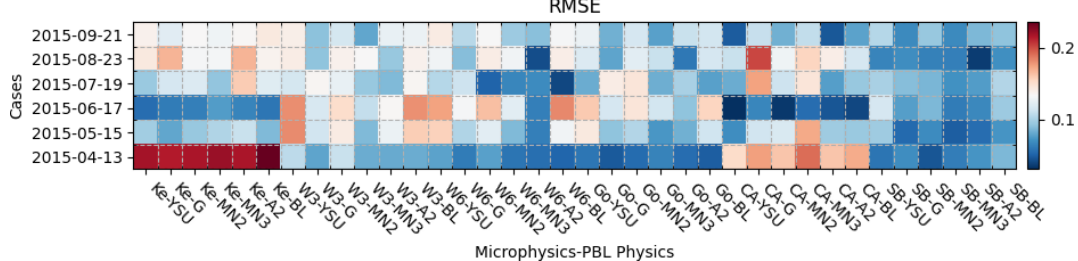
Figure 16. Heat map of the RMSE between the ensemble mean total cloud fraction and observation, averaged over the last 36h of the simulations, shown for each cluster of microphysics and PBL physics (columns) for all test cases (rows). In the color scale, red represents higher RMSE and poorer performance.